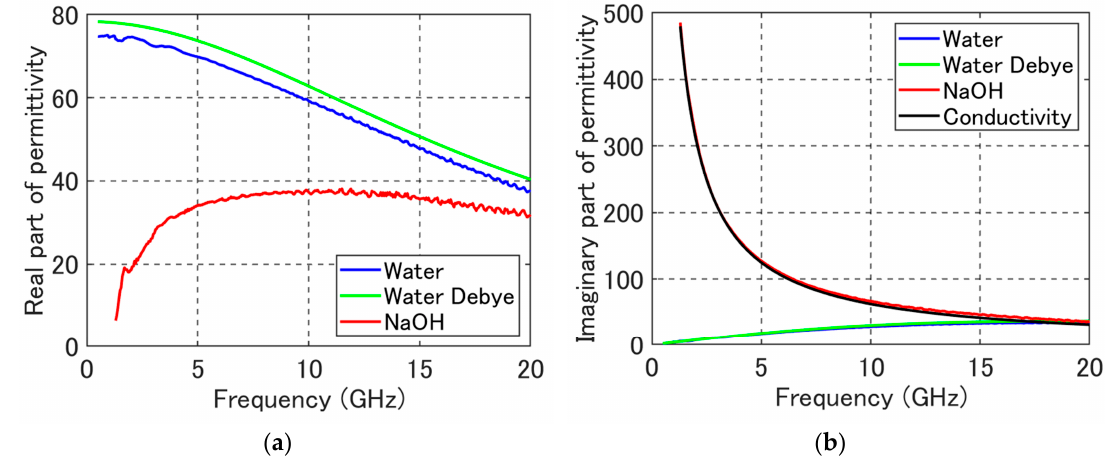
Figure 5. Measured results of the ( a ) real and ( b ) imaginary parts of the relative permittivity of the two different liquid samples. The average values of three measurements are plotted. The green lines plot the permittivity of the Debye relaxation model [28]. The black line in ( b ) plots the curve of σ / ( 2 π f ε 0 ) at the conductivity σ of 34.7 S/m.